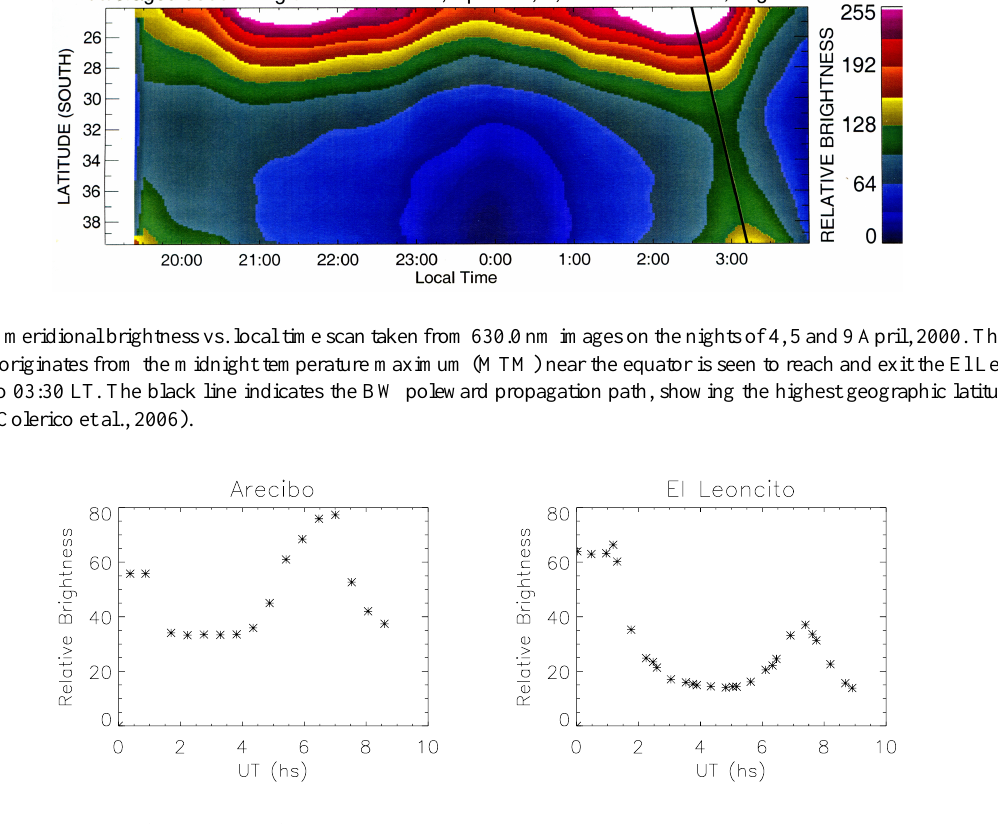
Fig. 6. Simultaneous detection of the passage of a BW at Arecibo and El Leoncito on 24 September 2003. Each point represents the average brightness of a 50 pixel-wide box centered at zenith. Notice the delay in the increase in brightness at the station further from the geographic equator (El